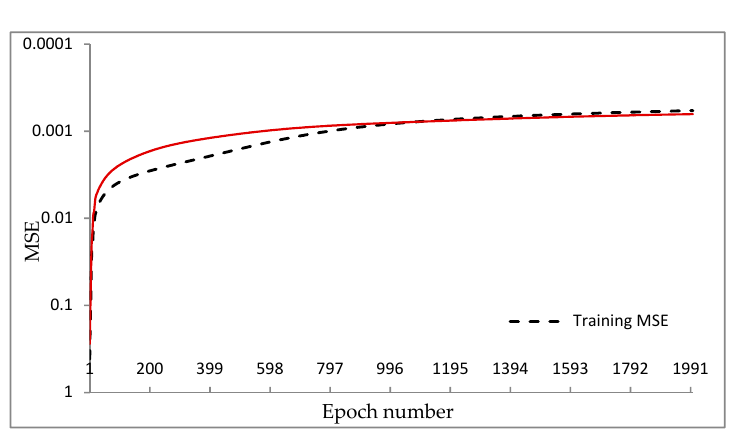
Figure 9. The MSE for the proposed SOFM model using 2000 epochs.